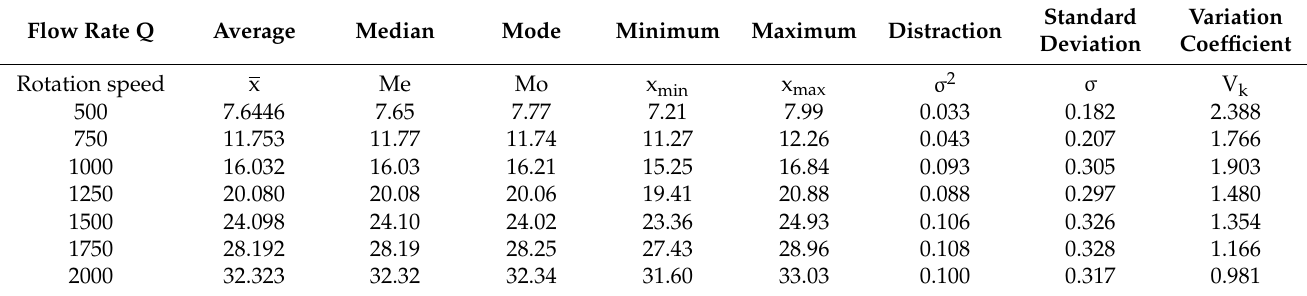
Table 9. Basic statistical evaluation, verification of flow characteristics of transducers in the secondary circuit.